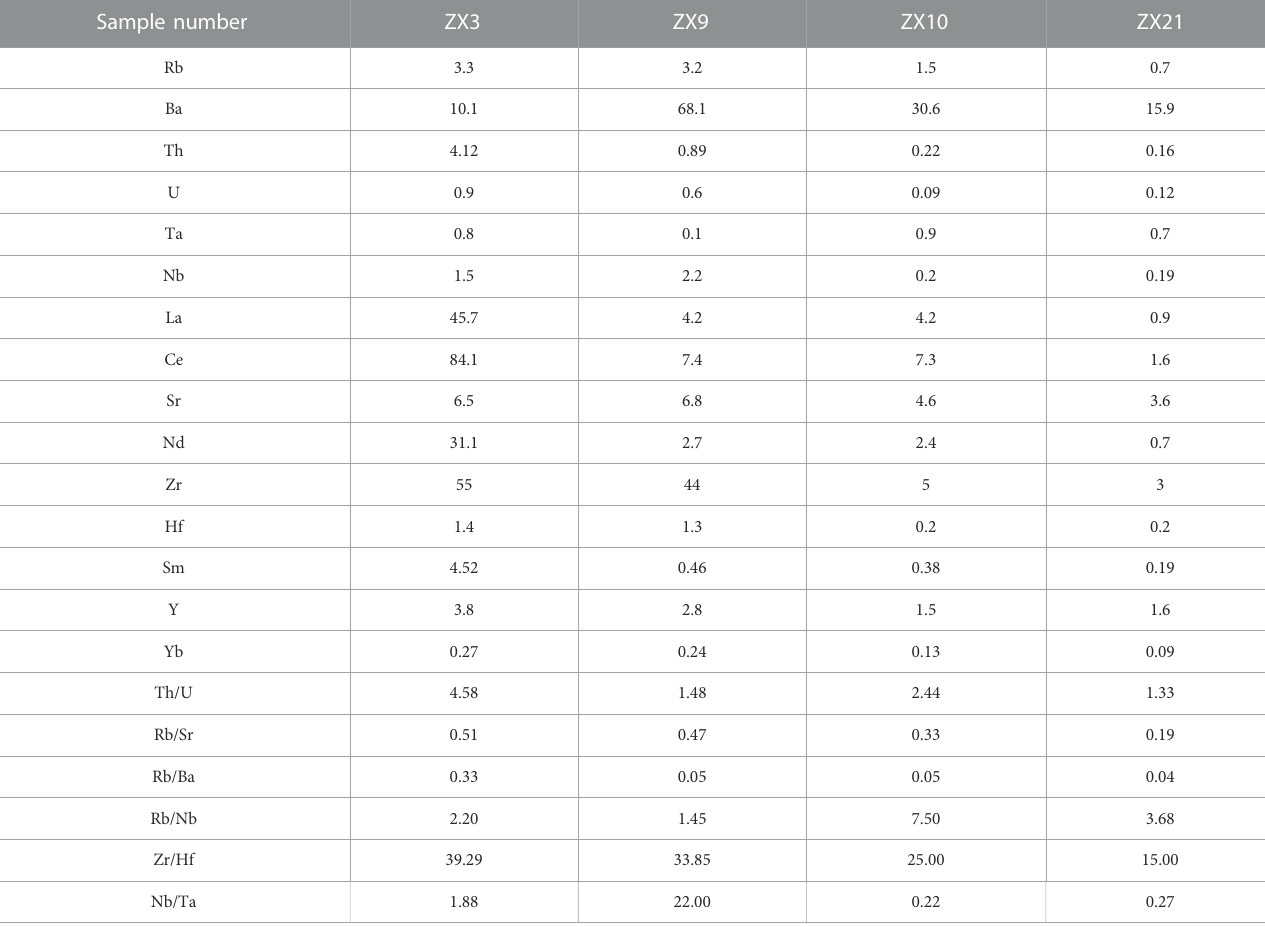
TABLE 2 Trace element contents and ratios of syn-ore granite at Zhaoxian (trace element unit: ppm). Sample